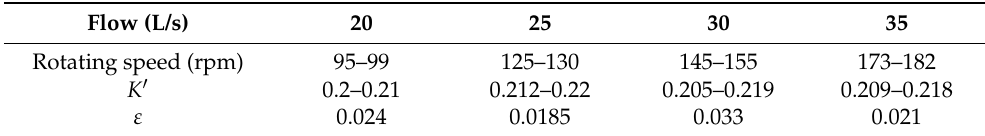
Figure 11. Surface pressure distribution of blades with different number of blades. ( a ) 6 − blade turbine stress distribution cloud map. ( b ) 7 − blade turbine stress distribution cloud map. ( c ) 8 − blade turbine stress distribution cloud map. Table 3. Fluid simulation